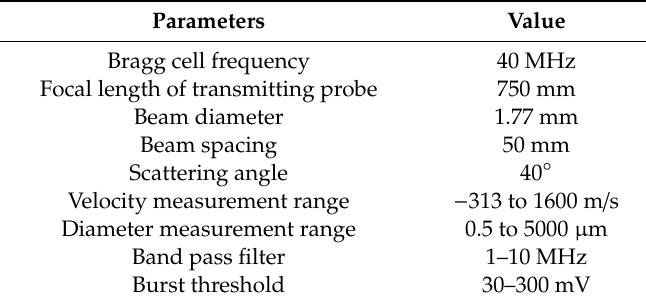
Figure 3. Installed phase Doppler particle analyzer (PDPA) system. Table 2. Optical setup and run settings of the PDPA system.